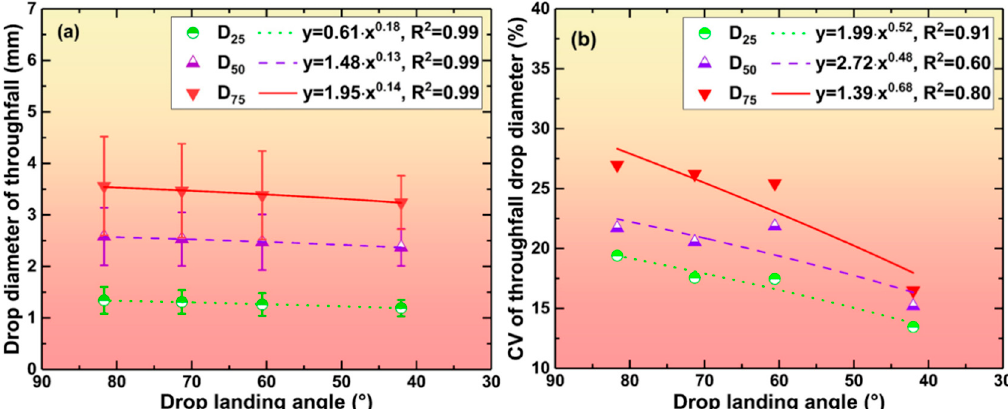
Figure 5. Inter-relationship among drop diameter of throughfall and its CV, and the drop landing angle. ( a ) presents the relationship between droplet size of throughfall and the droplet landing angle; ( b ) presents the relationship between the CV value of throughfall droplet particle size and the droplet landing angle.